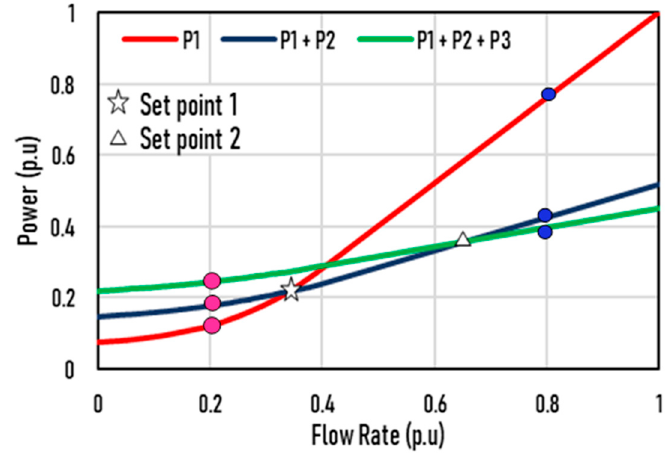
Figure 14. Single and multi ‐ parallel power